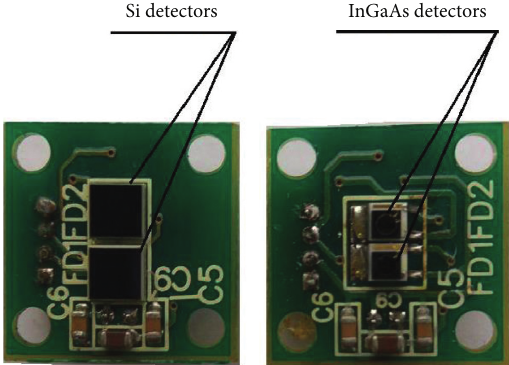
Figure 8: Design solutions of photodetectors for the optical units VIS and